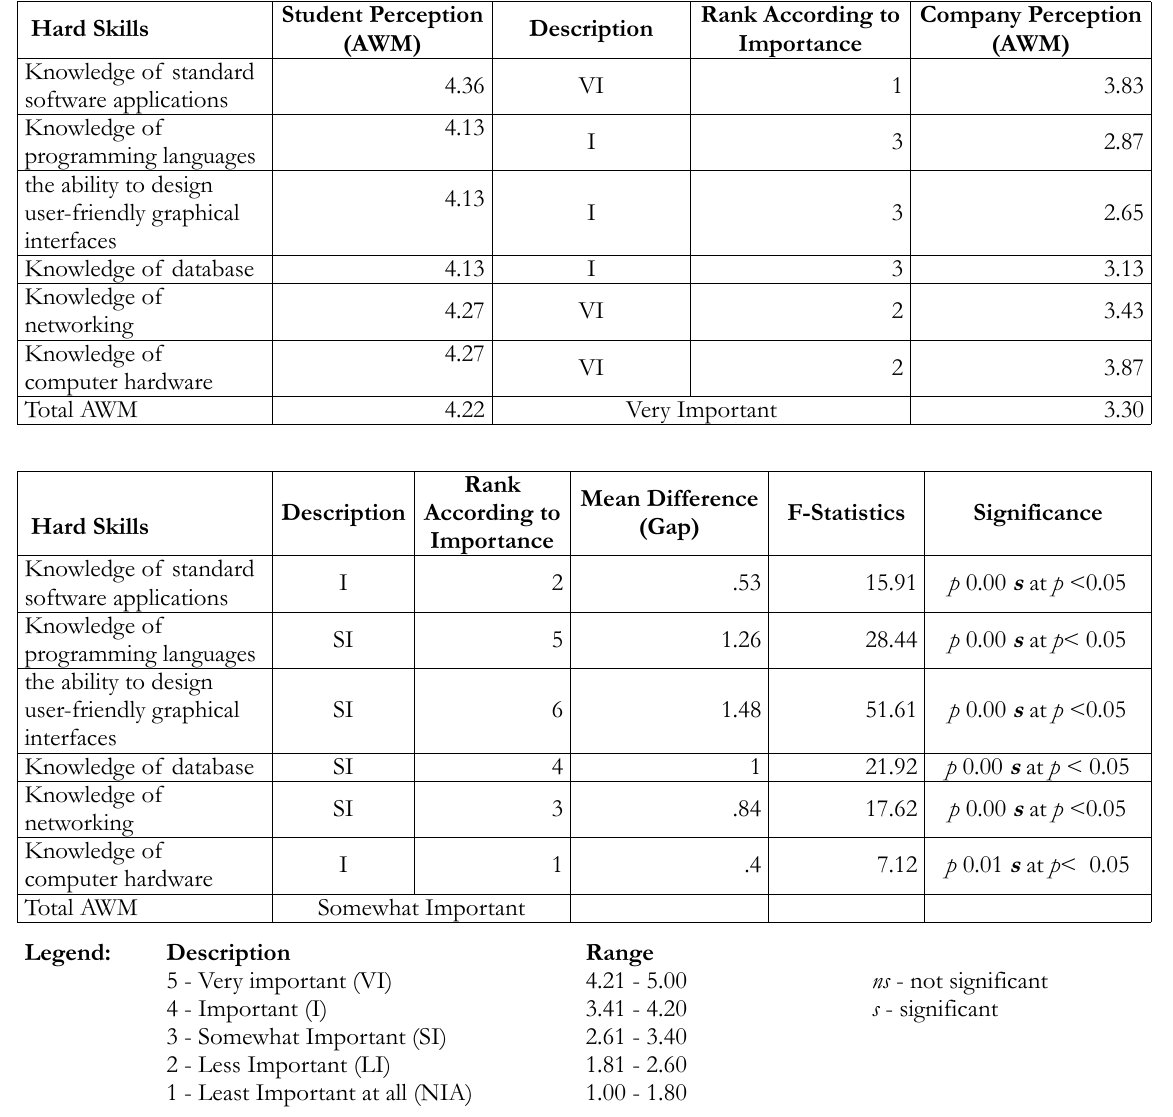
Table 4. Industry Partners and IT students Perceptions on the Importance of Hard Skills in the